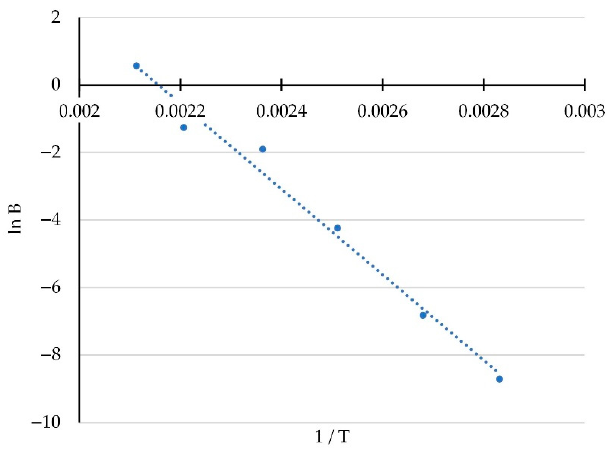
Figure 5. Arrhenius plot (Ø0.71 wire, 80–200 °C).